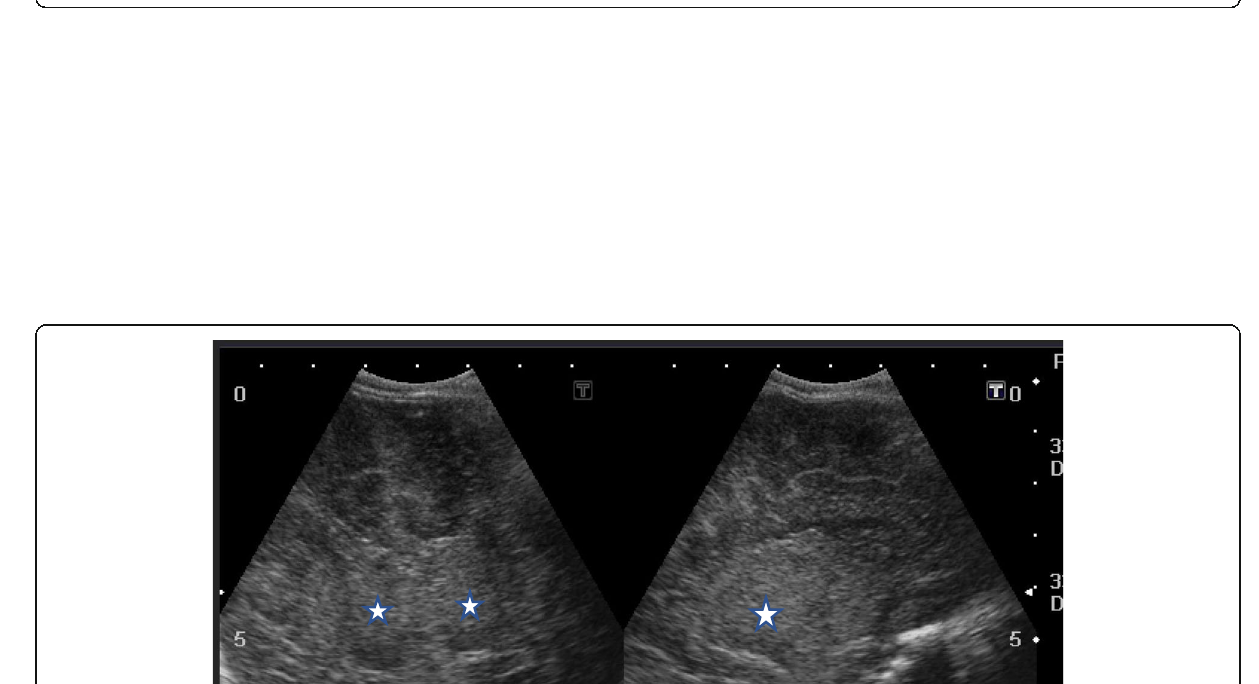
Fig. 6 Sagittal and coronal US image with Sarnat stage II showing right thalamic and smaller left thalamic focal echogenic areas (white arrow), representing thalamic hypoxic insult lesions